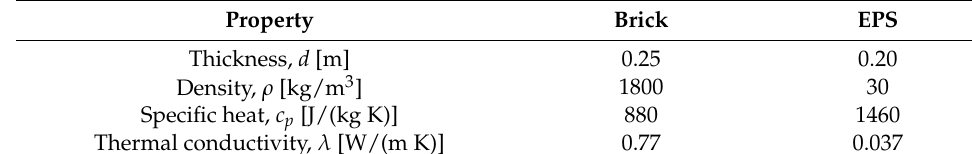
Table 1. Material properties assumed in the calculations. Property